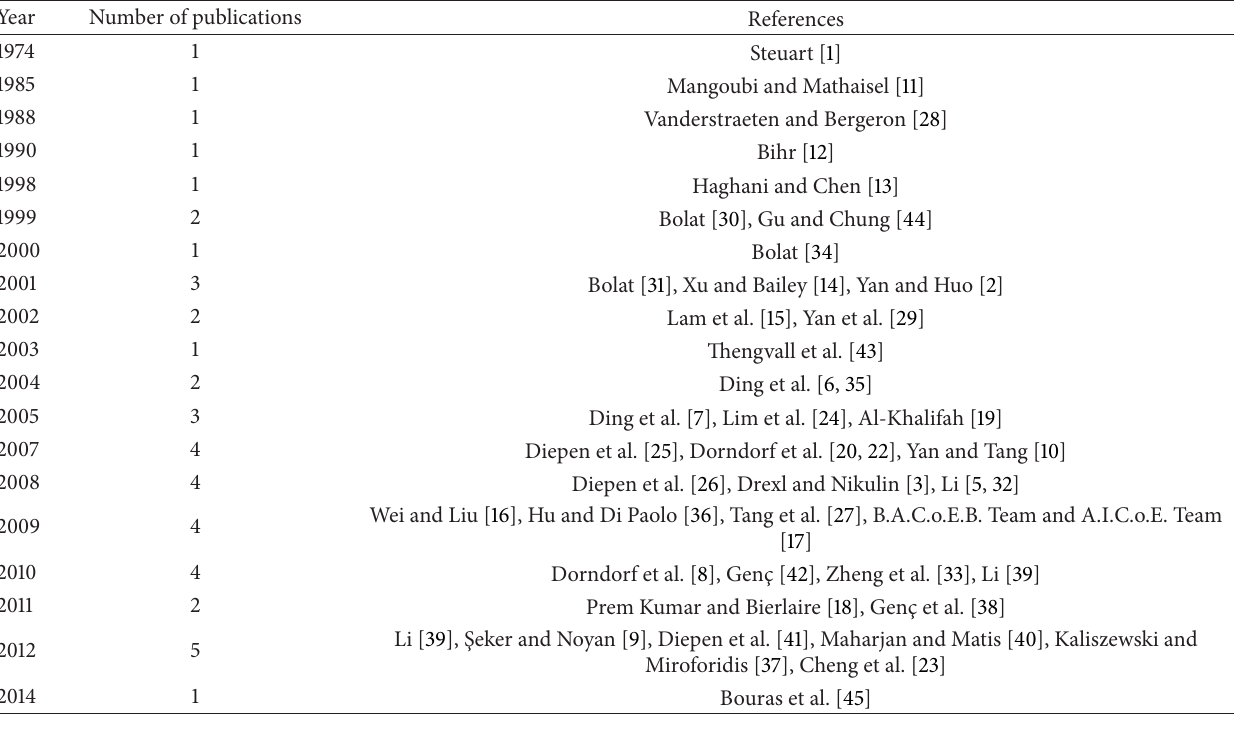
Table 3: Number of publications per year.